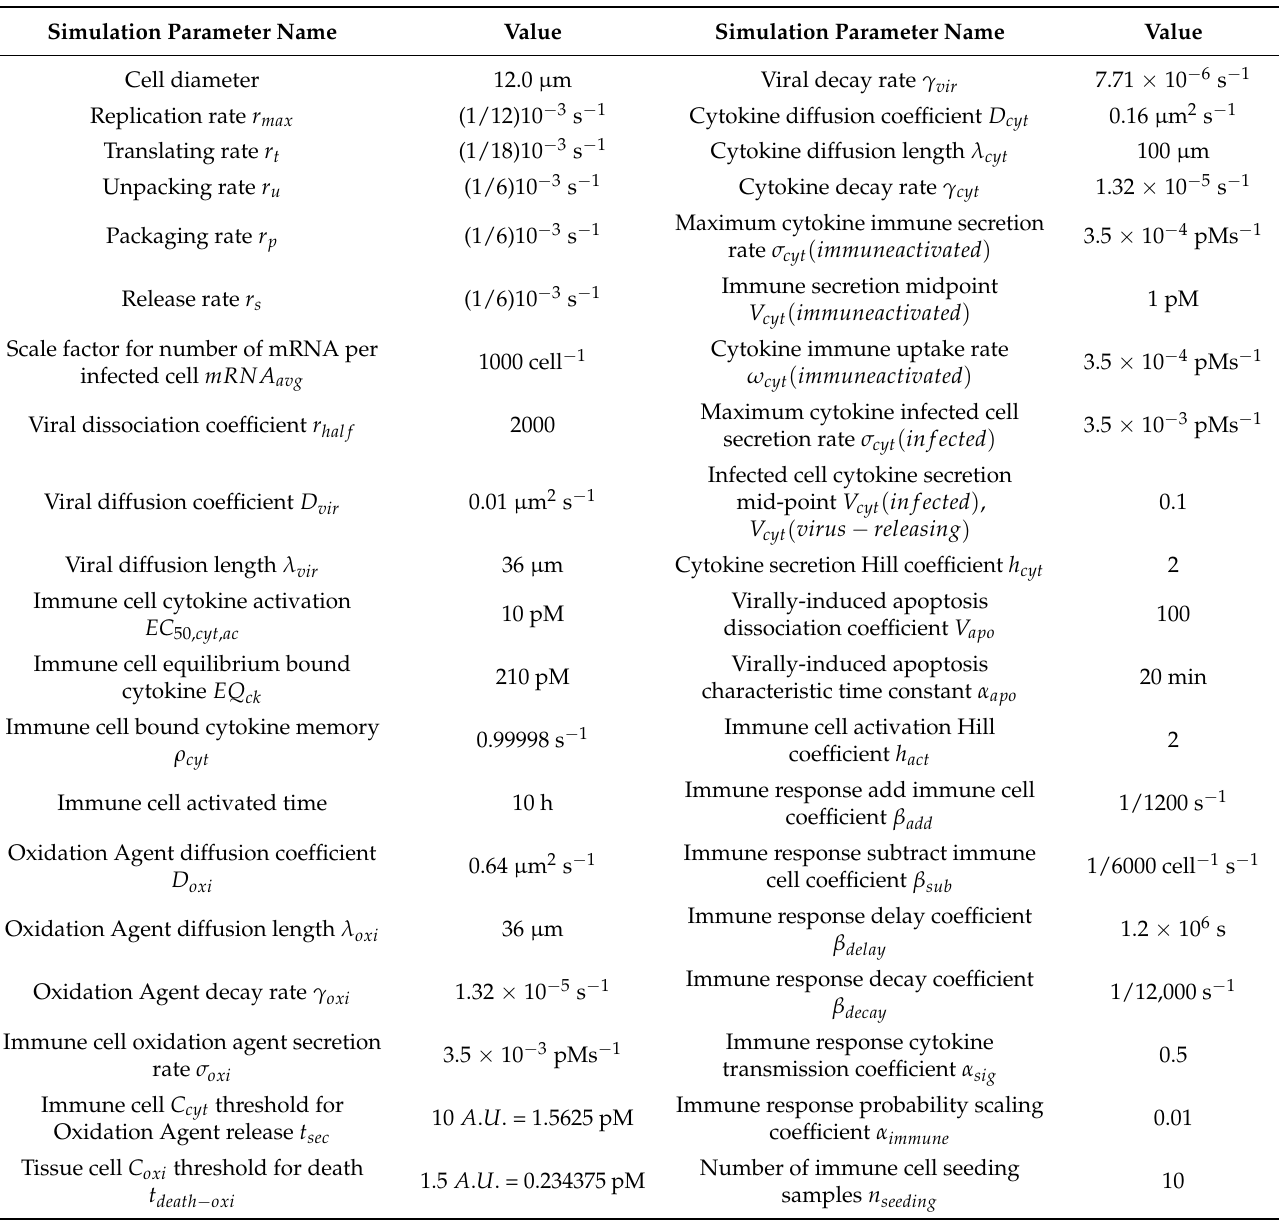
Table A3. Sego et al.’s parameters part